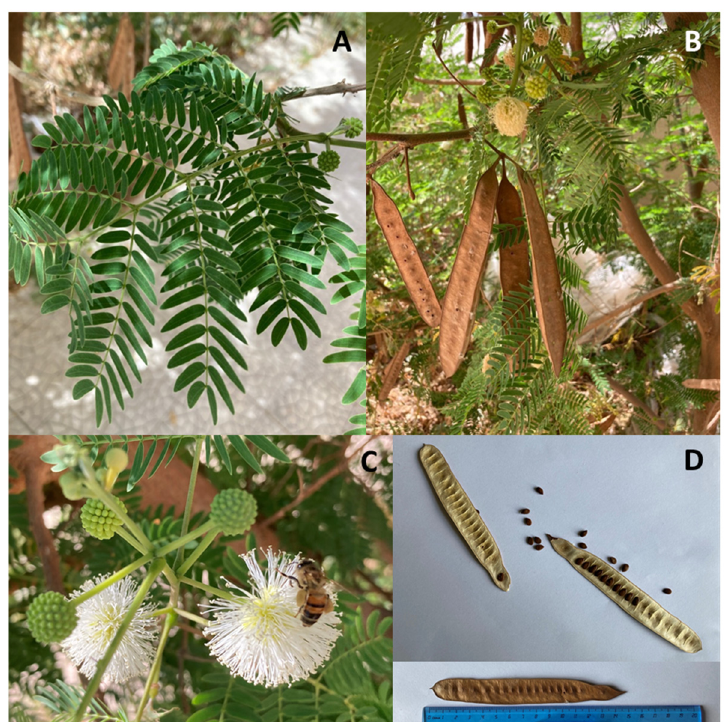
Figure 1. Leucaena leucocephala (Lam.) de Wit: ( A ) leaves; ( B ) flowers and ripened fruits; ( C ) honey bee foraging on Leucaena flowers; ( D ) pod and seeds (pictures kindly provided by Dr. Dipasquale D).